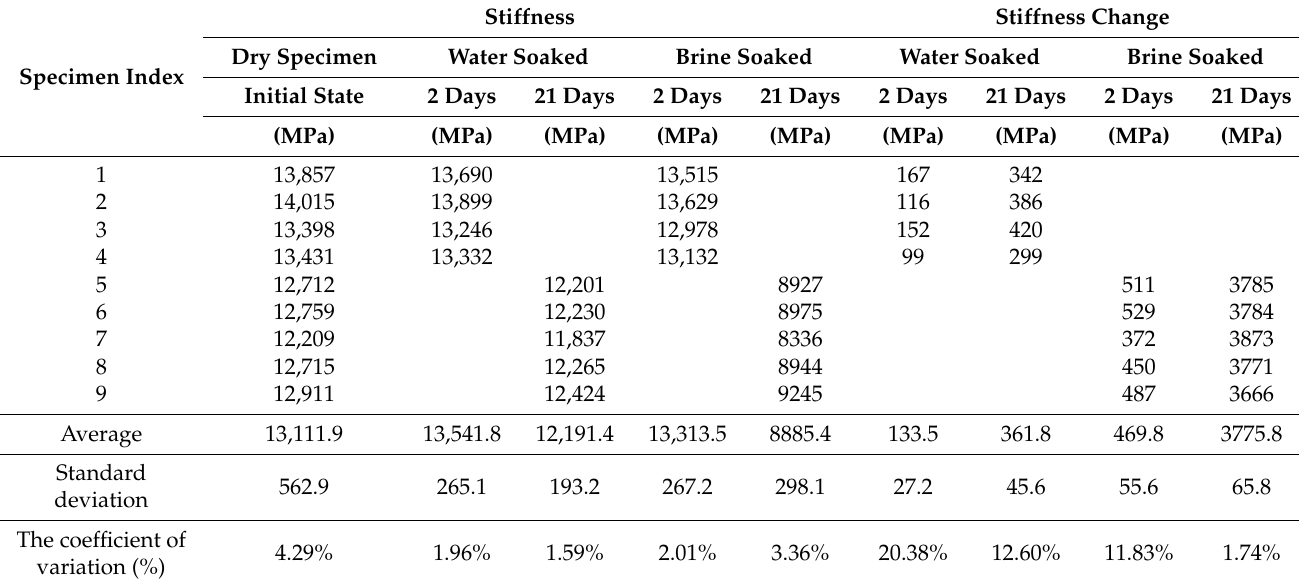
Table 6. AC22WMS(Pmb) mix stiffness variation via water and brine soaking.